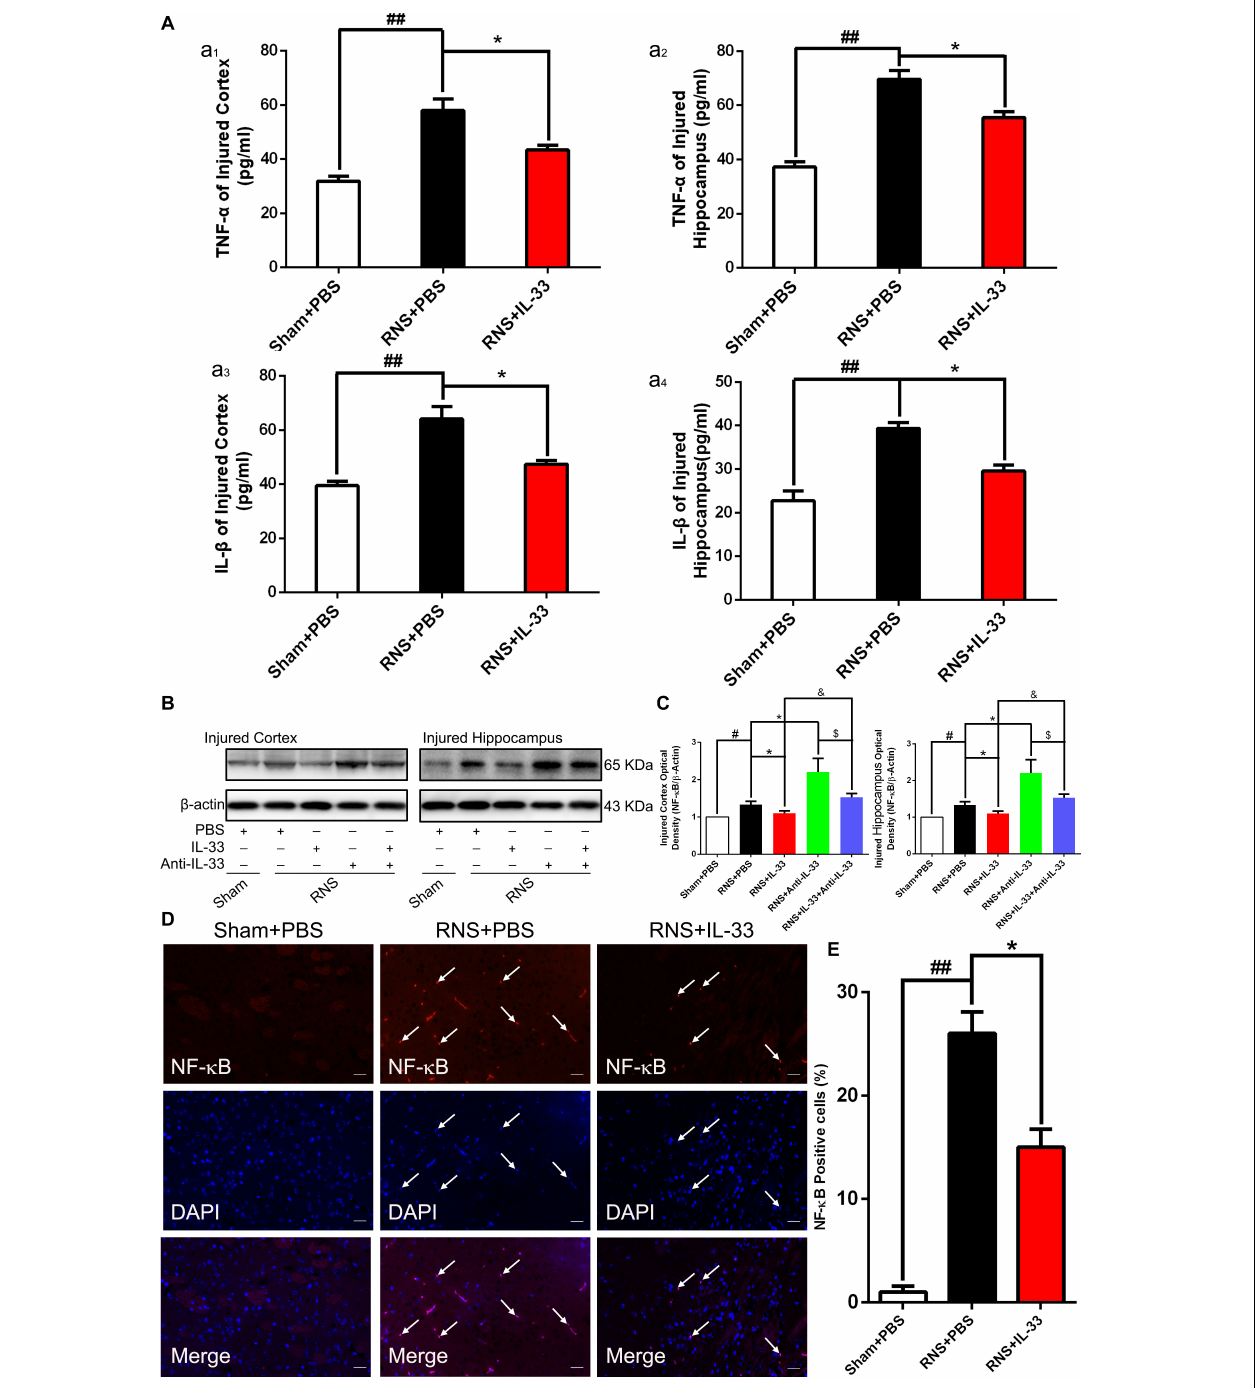
FIGURE 4 | IL-33 inhibited NF- κ B-mediated inflammatory responses after RNS. (A) ELISA was employed to assess the expression levels of IL-1 β or TNF- α at 72 h post-RNS. RNS-induced increase in TNF- α and IL-1 β expression levels were reversed by IL-33 pretreatment in the brain cortex (a1 and a3) and hippocampus tissues (a2 and a4) after a seizure. (B) An increase in NF- κ B activity caused by RNS was detected. Administration of IL-33 alone down-regulated the expression level of NF- κ B, while Anti-IL-33 alone treatment up-regulated the expression level of NF- κ B. However, the combined treatment of IL-33 and Anti-IL-33 reversed the effect of IL-33 alone or Anti-IL-33 on the expression level of NF- κ B, indicating that IL-33 inhibited the activity of NF- κ B at 72 h post-RNS, suggesting that IL-33 possesses a capacity to inhibit NF- κ B activity. (C) The optical densities of the protein bands were quantitatively analyzed, and normalized with loading control β -actin. (D) IL-33 treatment reduces nuclear NF- κ B expression. (E) Semi-quantitative analysis of NF- κ B-positive cells relative to the total number of cells. The data were expressed as means ± SEM ( n = 6). ## P < 0.01 vs. Sham + PBS group, # P < 0.05 vs. Sham + PBS group. * P < 0.05 vs. RNS + PBS group. & P < 0.05 vs. RNS + IL-33 group. $ P < 0.05 vs. RNS + Anti-IL-33 group Experiments are representative of three independent experiments.